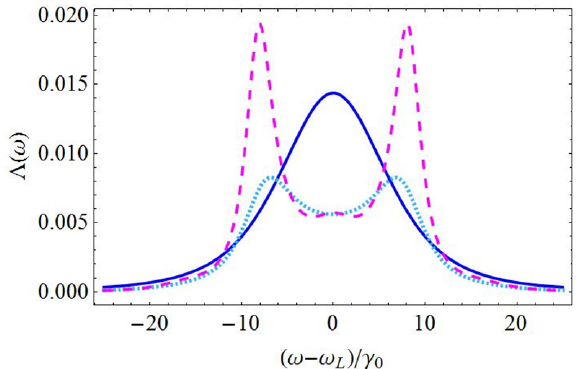
Figure 4. The resonance fluorescence spectrum, for Ω = 5 γ 0 , ω 21 = 15 γ 0 and ∆ = ω 21 /2. Curve styles and colors are modified, according to the value of the distance d between the QE and the nanosphere (blue solid curve: d = 10 nm, turquoise dotted curve: d = 27 nm and magenta dashed curve: d = 50 nm